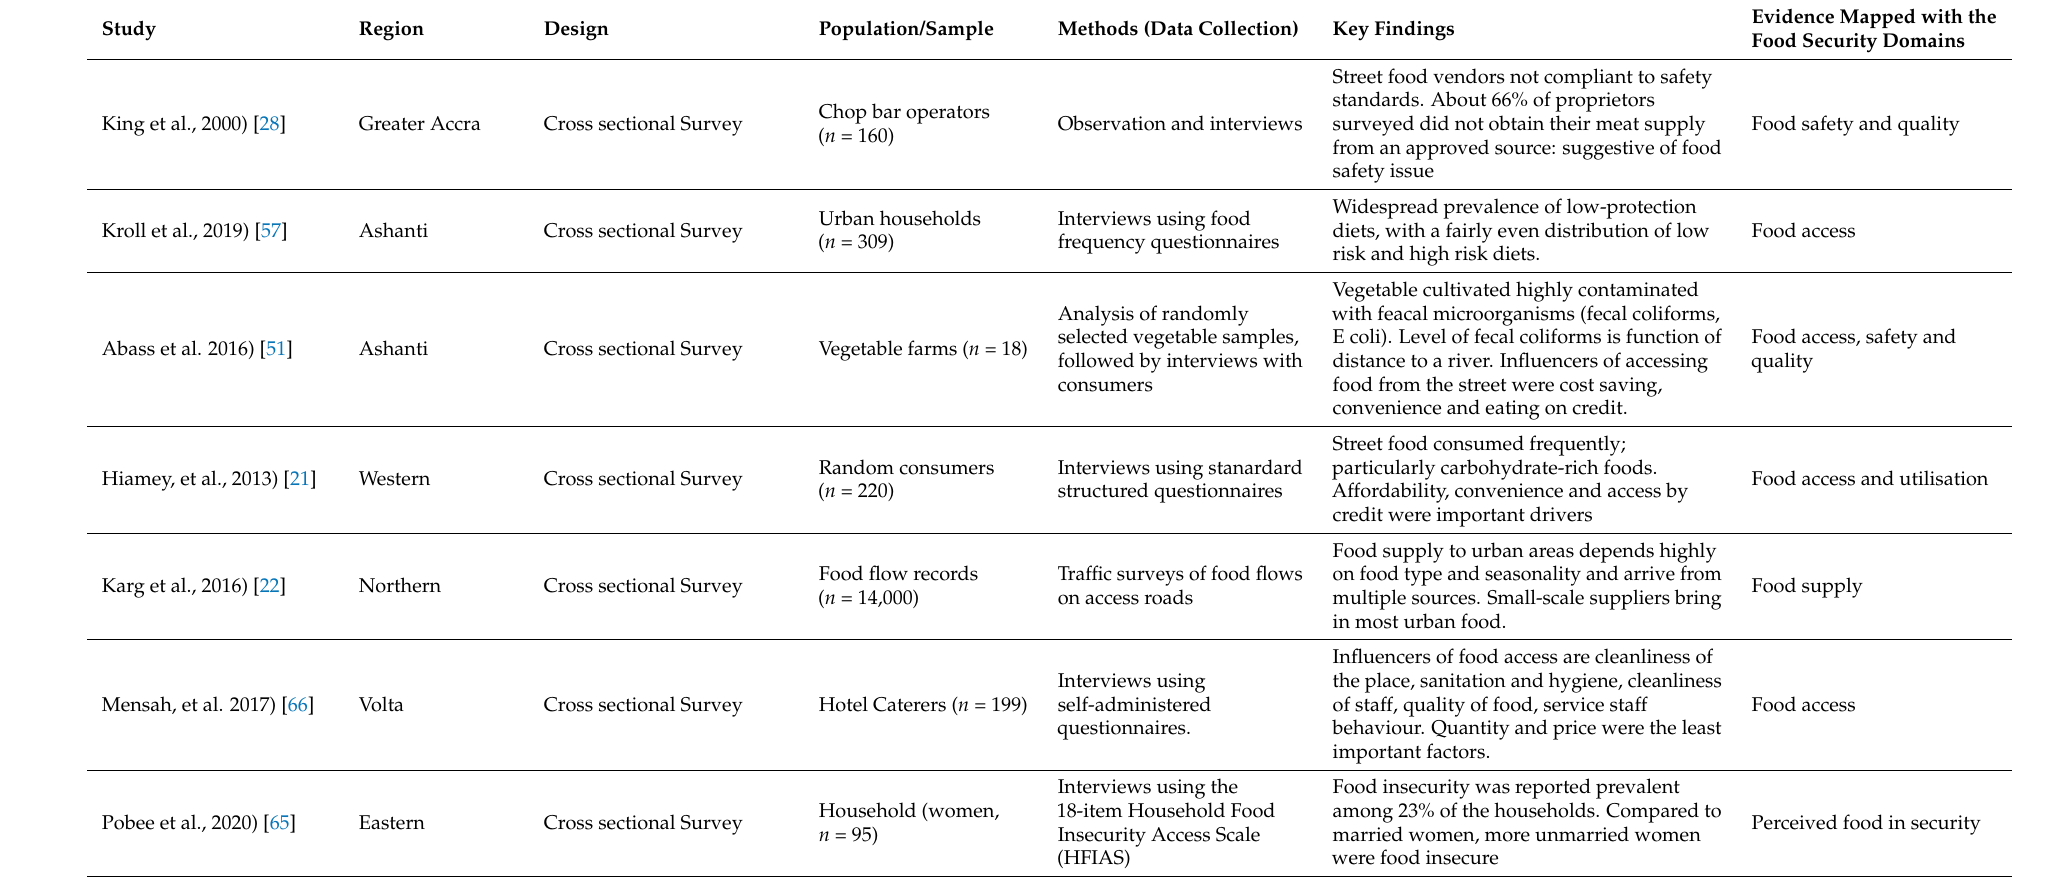
Table 1. Characteristics of 45 included studies and key